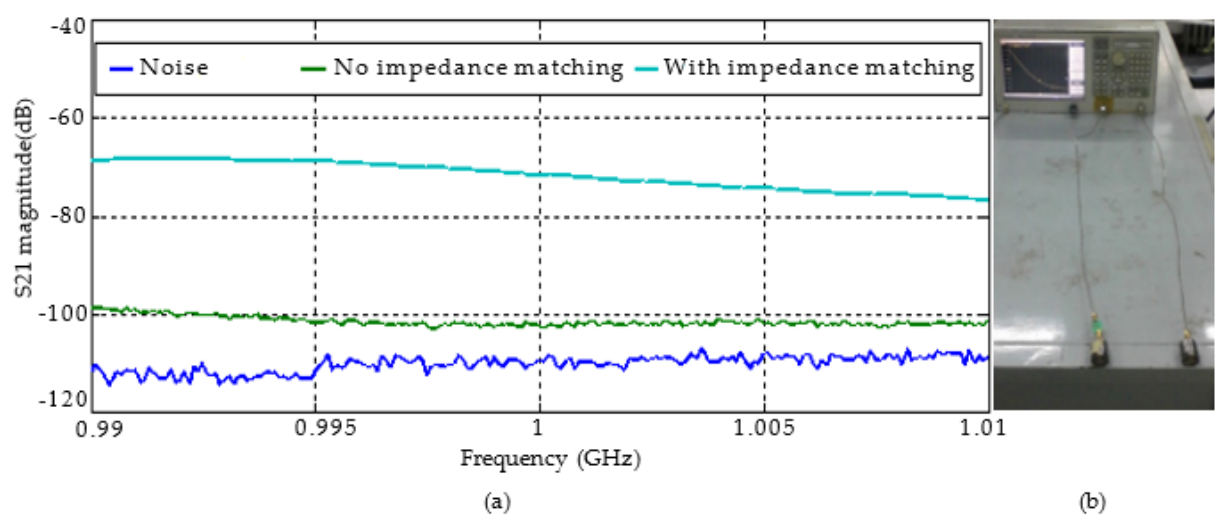
Figure 8. Simulation curve of transmission parameters of dual antennas.